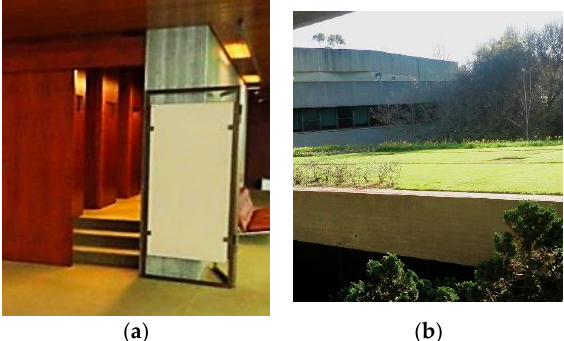
Figure 2. Technical sound room in the Calouste Gulbenkian Foundation: ( a ) entrance area and ( b ) green roof.